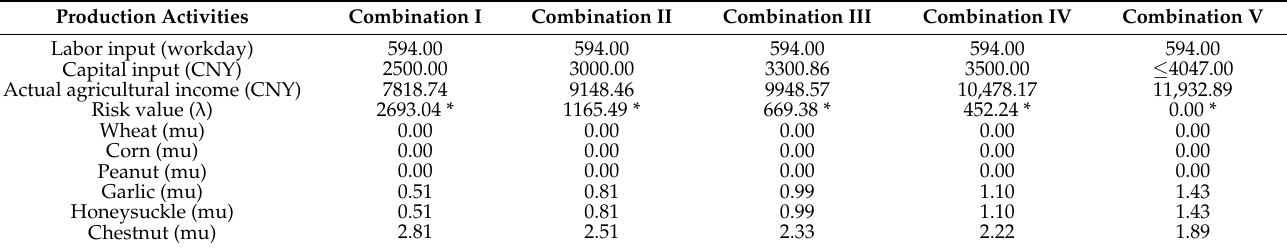
Table 10. Optimization of capital input for II PTPH .